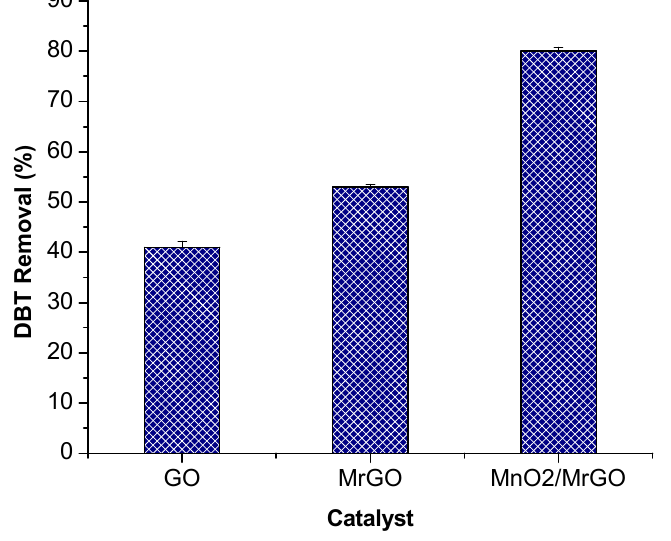
Figure 9. ODS of the modeled oil sample in the presence of GO, MrGO, and MnO 2 /MrGO . The advantage of the composite catalysts containing both MrGO and MnO 2 is evident because DBT removal is sufficiently increased compared to only GO as the catalyst. Sev- eral studies showed that metal oxides loaded on GO and other such supports (i.e., zeolites or alumina) increase the desulfurization yield in the presence of different oxidation sys- tems [55,56]. In ODS reaction, these metal oxides lead to the formation of peroxo species, which can oxidize sulfur compounds. For example, using MoO x /Al 2 O 3 as a catalyst with H 2 O 2 as the oxidizing agent, DBT oxidation takes place through the formation of hydrop- eroxymolybdate species, which were formed upon the electrophilic attack of H 2 O 2 over octamolybdate and heptamolybdate species [57]. In the current system, manganese diox- ide supported on MrGO is assumed to enhance the oxidation of DBT, leading to higher desulfurization yield than GO because MnO 2 /MrGO offered high DBT removal efficiency. An appropriate pathway is presented for a better understanding of the mechanism of ODS by the H 2 O 2 /formic acid system in the presence of MnO 2 /MrGO as the catalyst. In the current study, the reaction is initiated by MnO 2 , involving the heterolytic cleavage of H 2 O 2 , and thus producing active hydroxyl radical (OH . ); hydroxyl radicals are strong ox- idizing agents [40], which further attack formic acid to produce performic acid. Performic acid offers its oxygens to DBT in order to form DBT sulfoxide and then DBT sulfone. It is also possible that the peroxyl group, produced by the reaction between H 2 O 2 and HCOOH, interacts with the surface of MnO 2 , which carries out the selective oxidation of the S atom when DBT is adsorbed on the catalyst’s surface [58]. The proposed mechanism is presented in Scheme 1. Here, GO acts as support, but due to its two-dimensional geometry, electron transfer capability, and ability to form π -complexes with sulfur compounds, it further enhances the desulfurization yield [59].